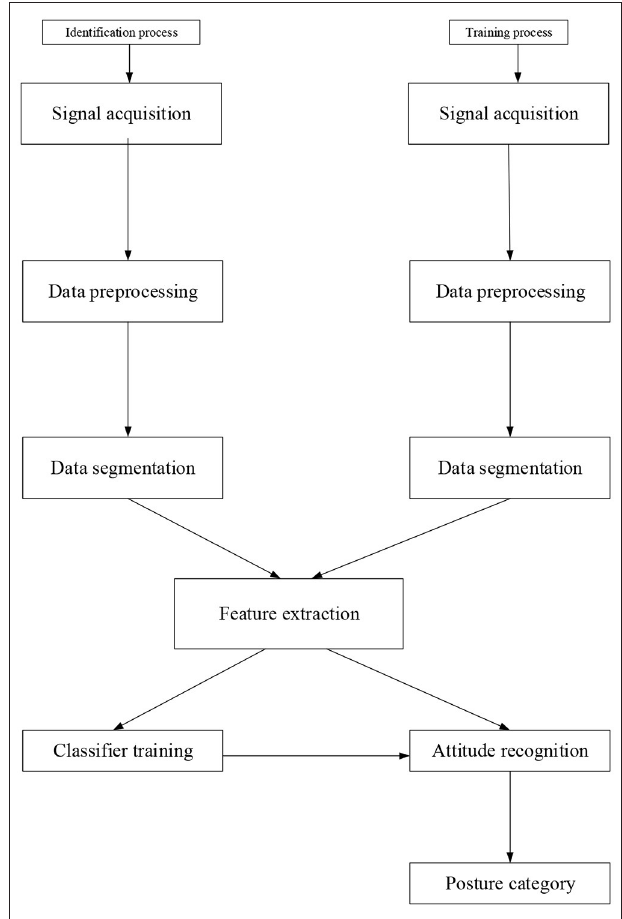
FIGURE 1 | Method flow of human posture